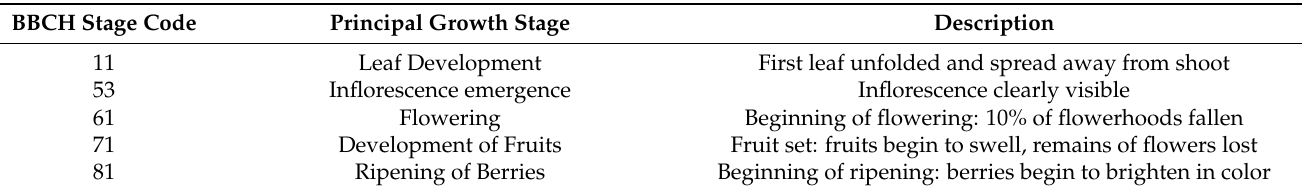
Table 1. Description of vineyard phenology according to BBCH scale [58].